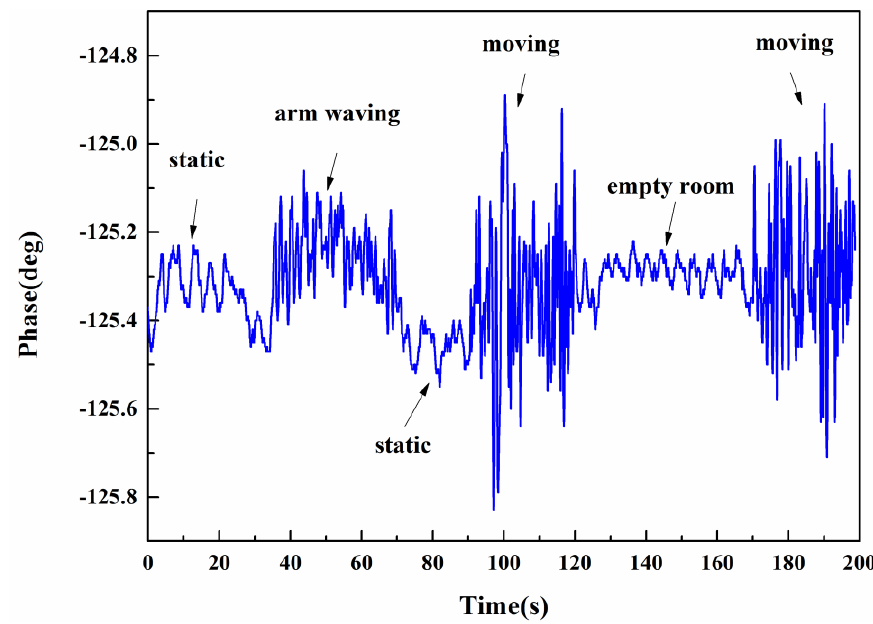
Figure 7. Vital sign signals when a human subject performs different actions (standing still, arm waving, moving, leaving the room) in through-wall scenarios.